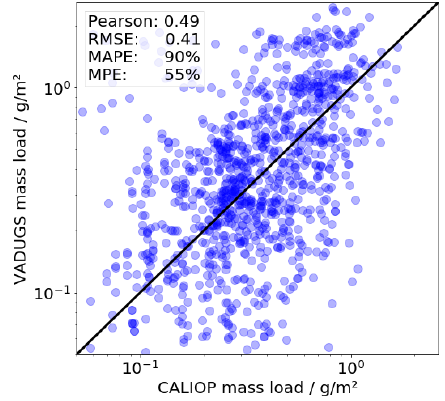
Figure 10. CALIOP and VADUGS retrievals of VAMC; the black line represents the